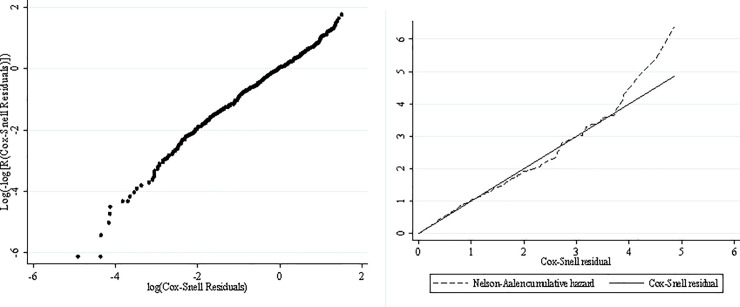
The Cox-Snell residual diagram of the exponential frailty model.